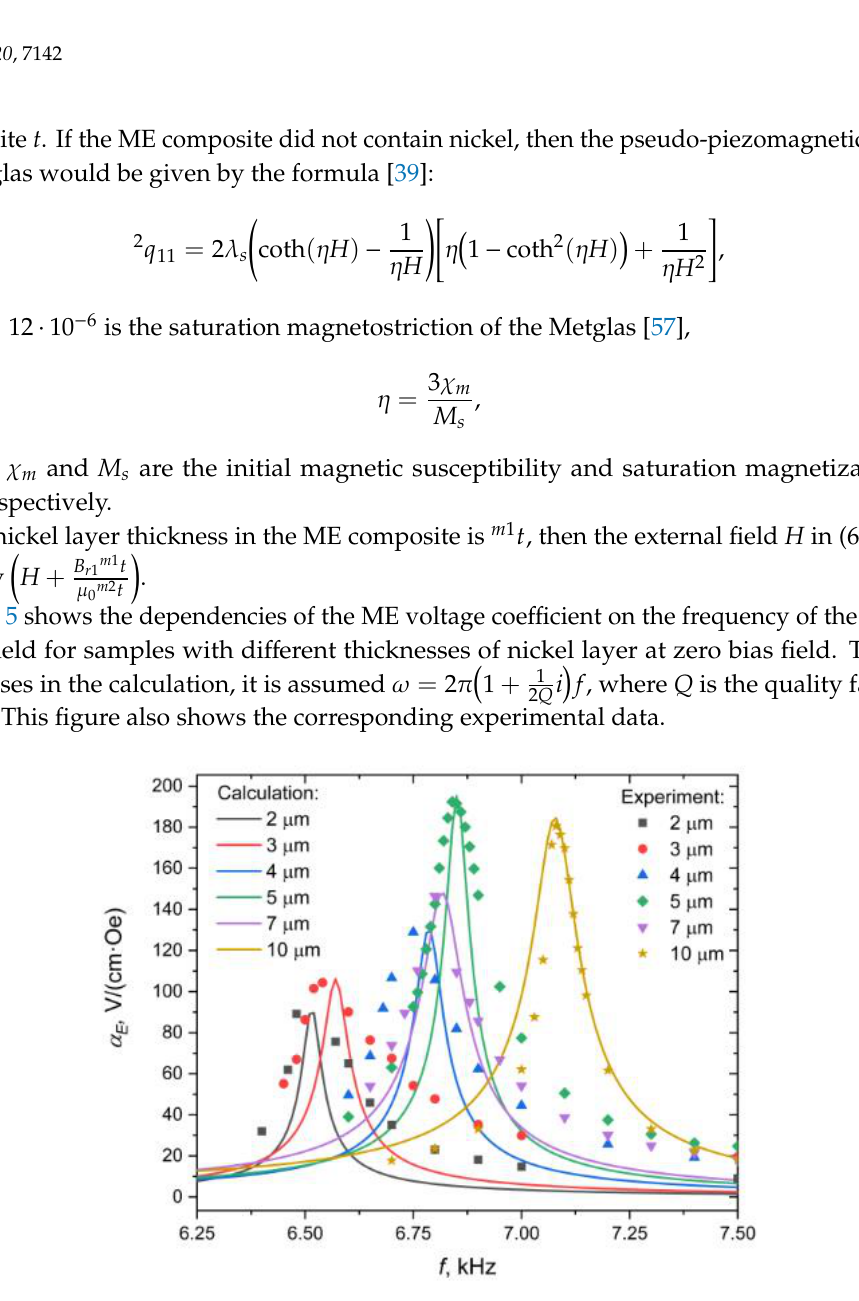
Figure 5. Dependence of the ME voltage coefficient on the frequency of an alternating magnetic field for samples with different nickel layer thicknesses at zero bias field. Points are experimental data, solid lines are theoretical dependencies. When the experimental dependencies were taken, the amplitude of the alternating magnetic field was 1 Oe.